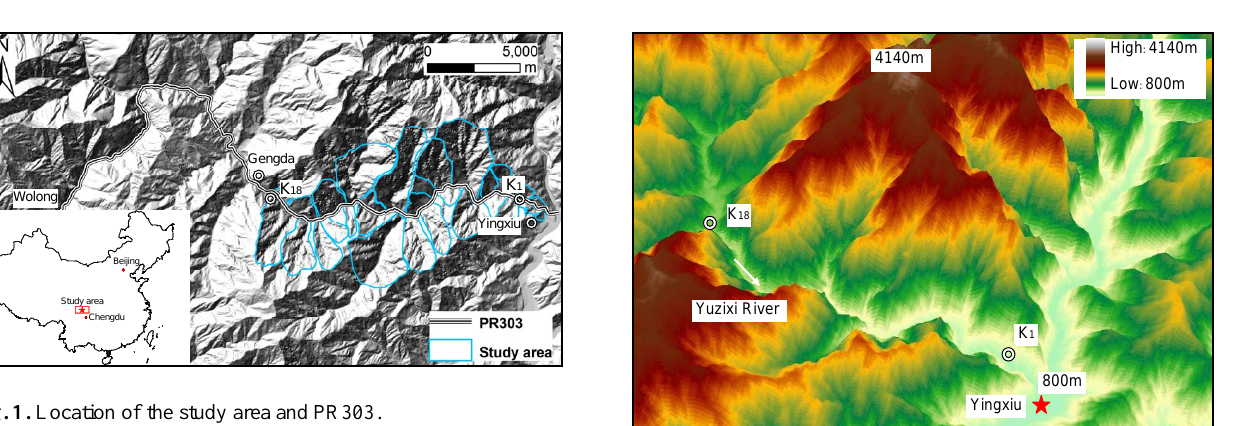
Fig. 1. Location of the study area and PR303.